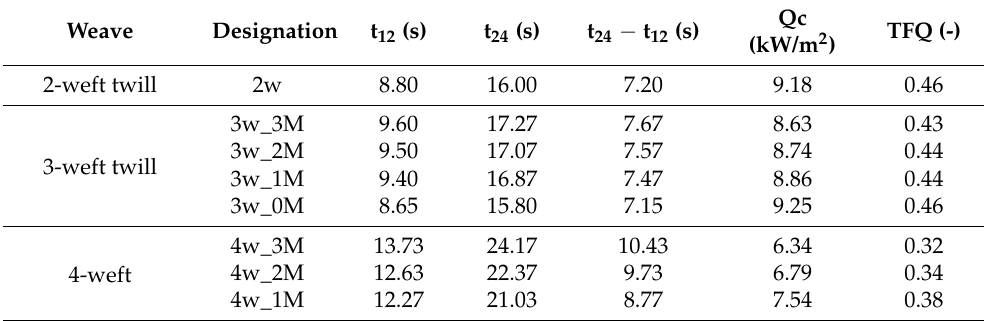
Table 3. Fabric resistance to radiant